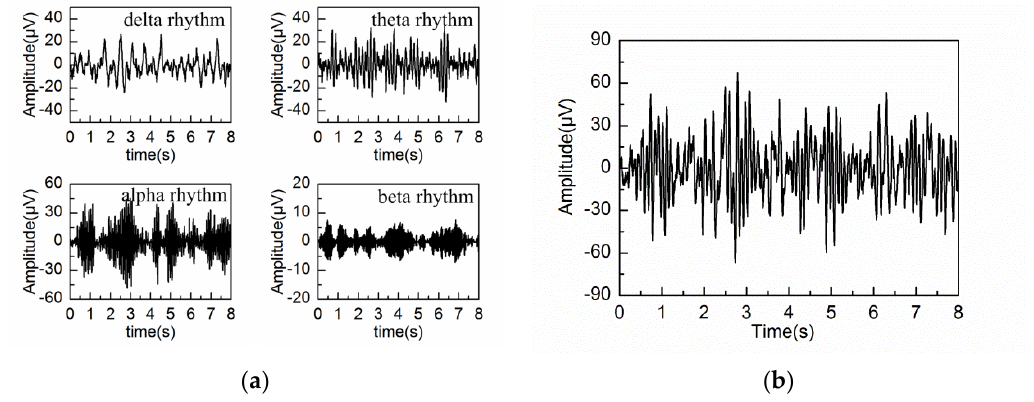
Figure 2. The simulation process of the spontaneous electroencephalography (EEG) signal: ( a ) simulated delta, theta, alpha and beta rhythm; ( b ) the spontaneous EEG signal constructed by the superposition of the four rhythms.